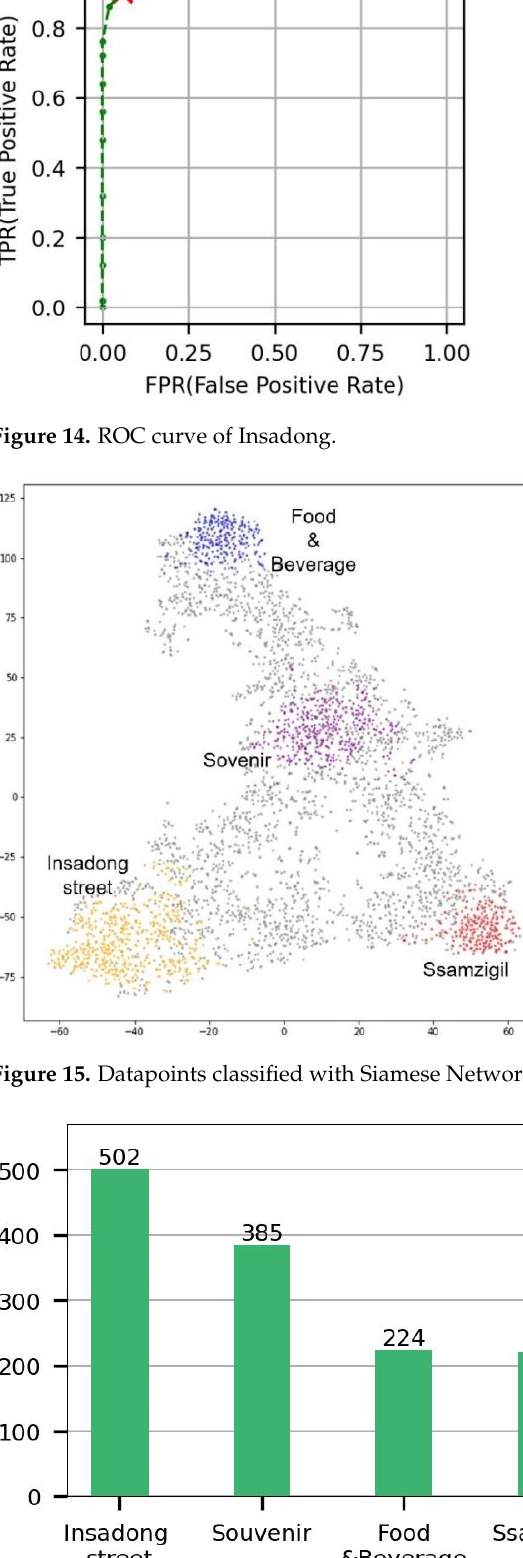
Figure 16. Number of photos by category in